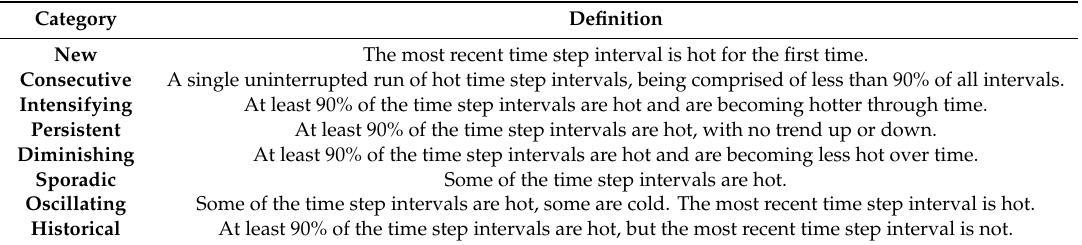
Table 2. Definitions of various hot spots in